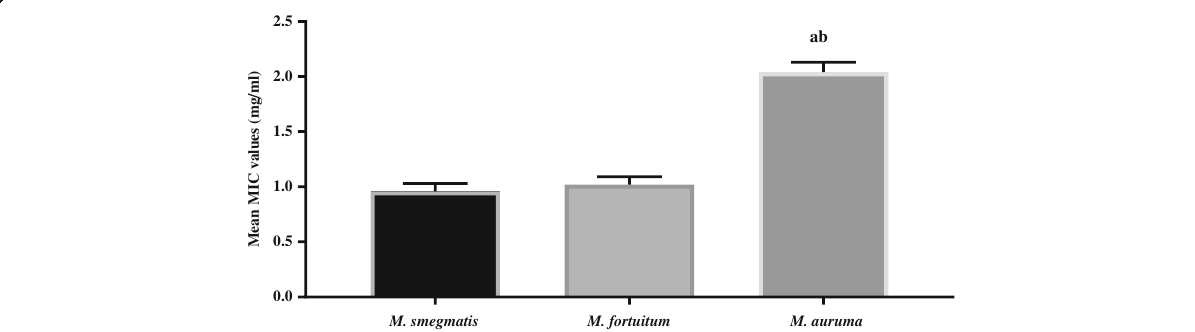
Fig. 2 Sensitivity of the tested Mycobacterium spp. to the different plant acetone leaf extracts. Legend: ab = statistically significant difference in mean MIC, p < 0.05, when the sensitivity of M. aurum was compared to the MIC values of M. smegmatis and M.